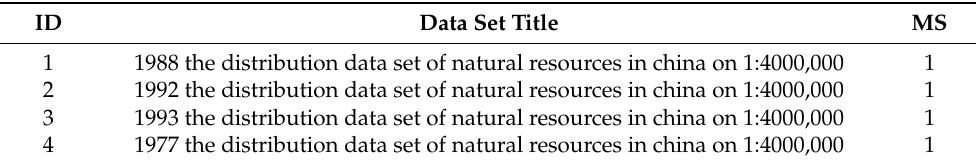
Table 6. Retrieval results of keywords matching method in 7169 data sets of